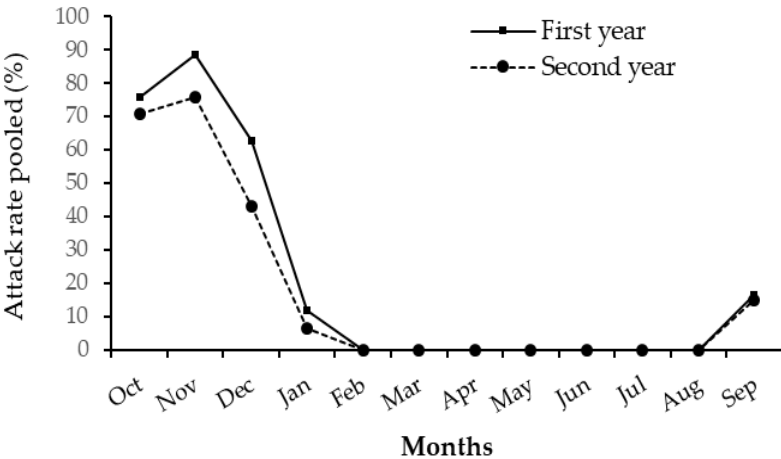
Figure 4. Monthly evolution of attacks across all sites per year. First year: October 2015–September 2016; Second year: October 2016–September 2017.